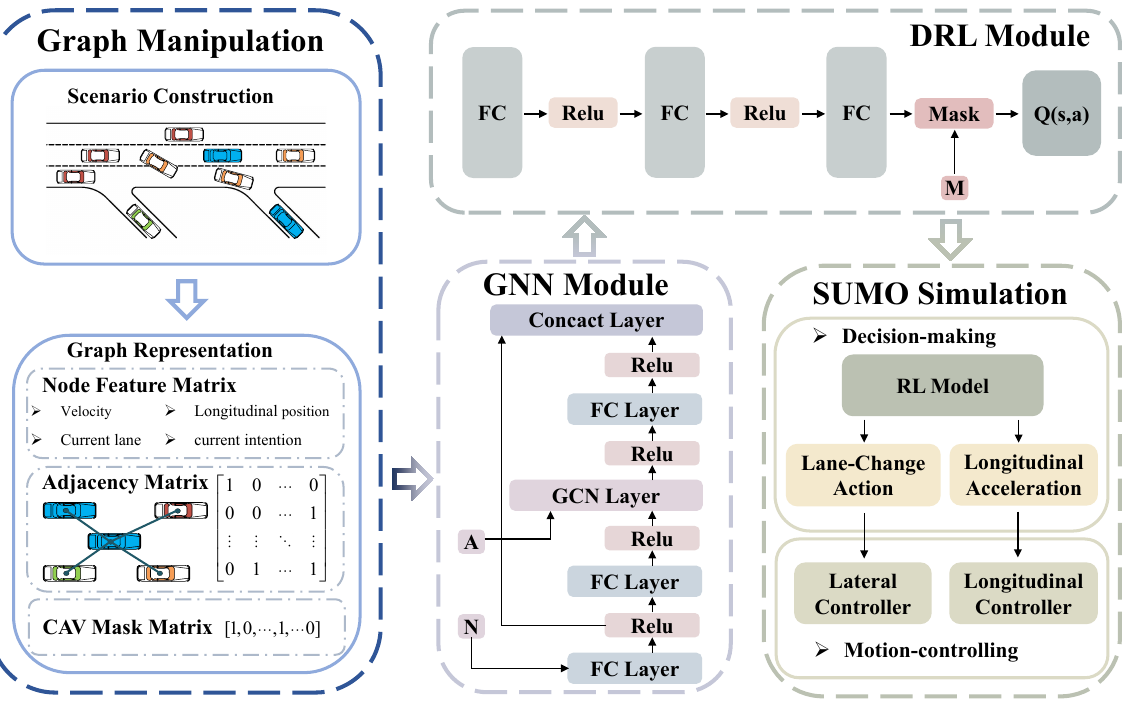
Figure 1. The schematic diagram of the designed framework. Letters N, A, and M represent node feature matrix, adjacency matrix, and CAV mask matrix